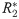
Extended qMRI processing of the RESUME protocol.Axial brain slices of: 1) R2* map ([0 ∼ 50] s−1); 2) R1 map ([0 ∼ 2] s−1); 3) PD map ([0 ∼ 1] arbitrary units); 4) QSM ([−300 ∼ 300] ⋅ 10−9); 5) MAVEN vein segmentation; 6) OEF map ([0 ∼ 0.4]); 7) MTVF map ([0 ∼ 0.5]). MAVEN segmentation is Maximum-Intensity-Projected on a slab thickness of 20 mm and fused on the minimum-Intensity-Projection of the corresponding SWI slab (computed from the second echo of the dual-echo GRE), which serves as anatomical reference.